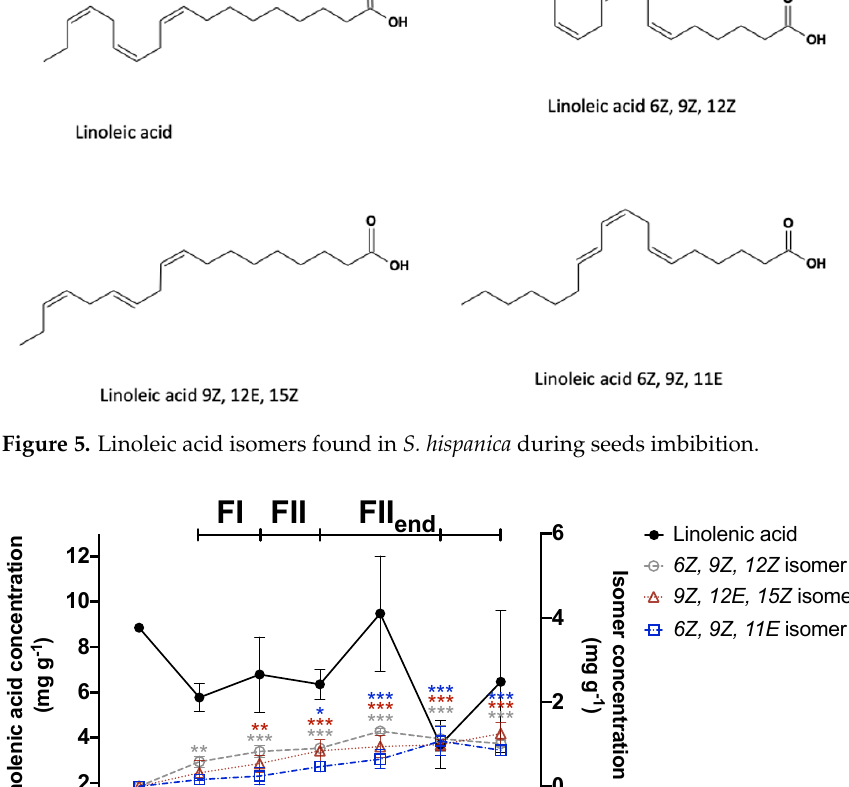
Figure 4. Fatty acid concentration changes in S. hispanica seeds related with imbibition stages (FI, FII and FII end ) at 10, 20 and 30 °C. Concentrations were calculated relative to the weight of non-imbibed seeds (NI) within the total weight. Values are expressed as mean ± SD of three independent replicates. Statistical analysis was performed using two-way ANOVA followed by a Dunnett multiple comparison test. Asterisks correspond to data with statistical differences regard with control concentration in NI (* p = 0.033; ** p = 0.002; *** p < 0.001).